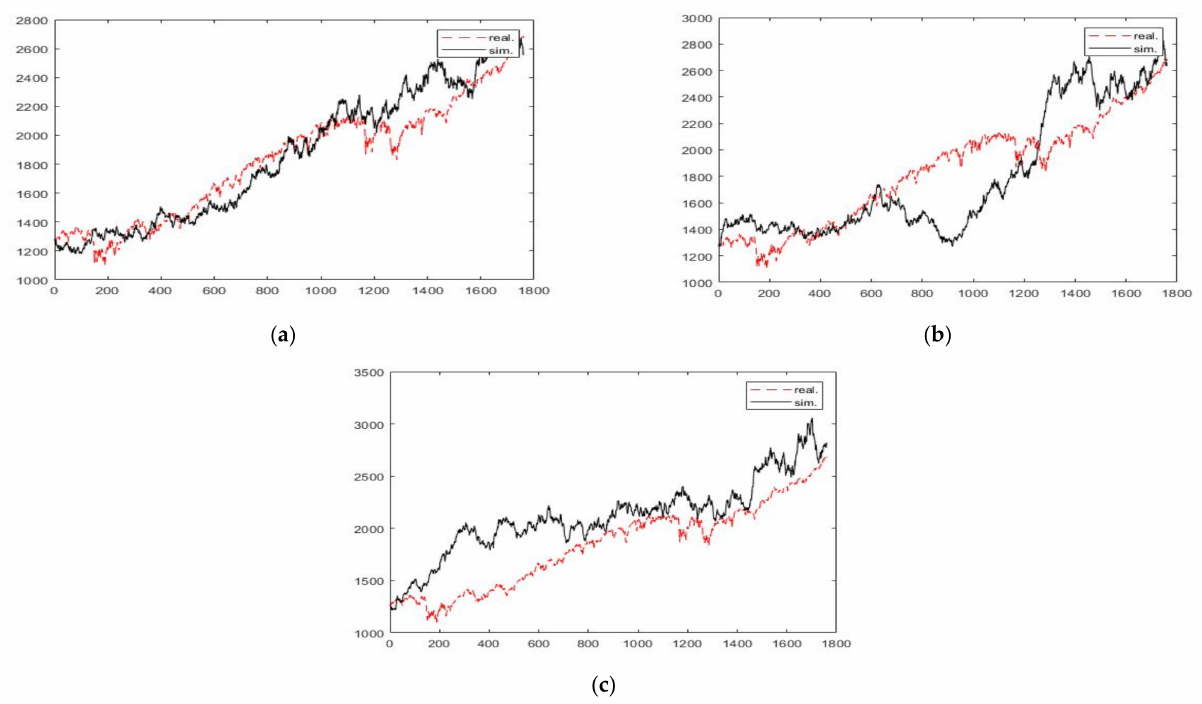
Figure 3. Simulation results using GFBM (7-year period): ( a ) Hurst PE, ( b ) Hurst RS, ( c ) Hurst